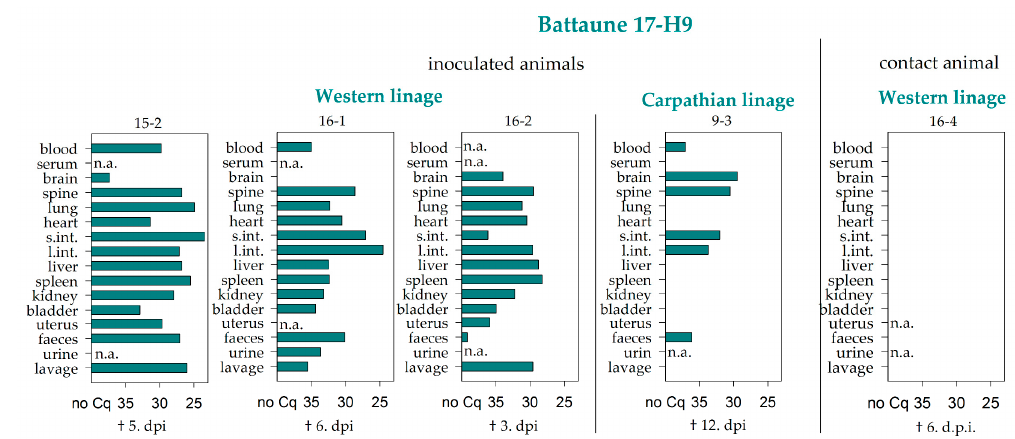
Figure 4. RT-PCR results of the bank voles that had to be taken out prior to the endpoint. The day of removal is given underneath the respective graph as days post infection (d.p.i). Missing samples are marked with n.a. (not